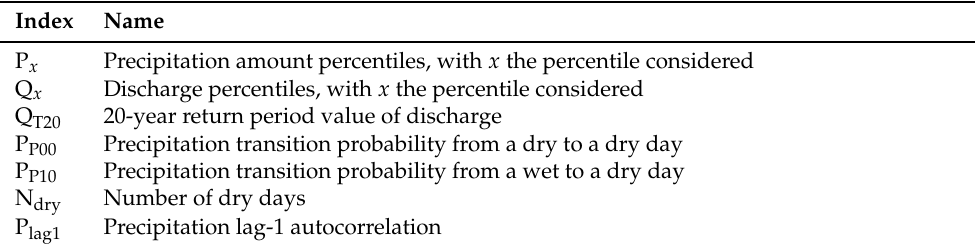
Table 1. Overview of the indices